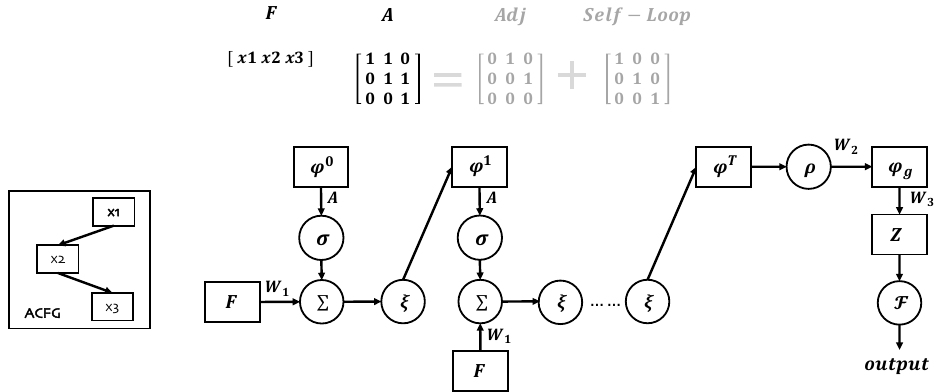
Figure 6. Structure of the graph neural network. The input ACFG is divided into two matrices: a feature matrix and an improved adjacency matrix with a self-loop. The output is the vulnerability probability of the